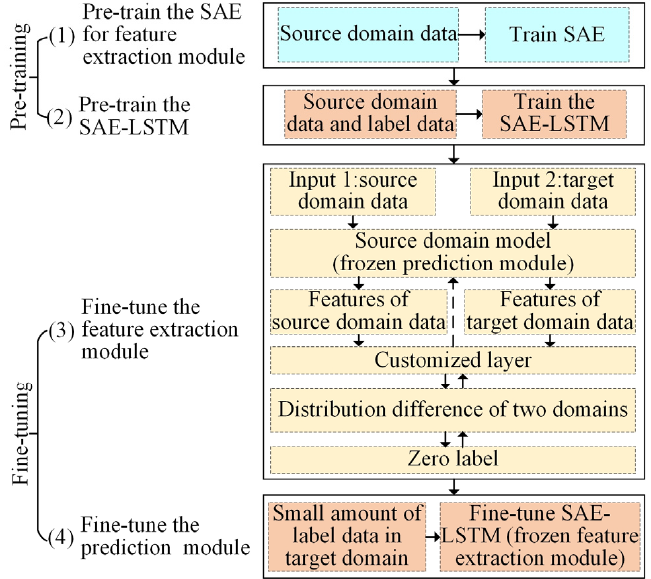
Figure 4. Transfer learning strategy based on a multi-stage model training process.